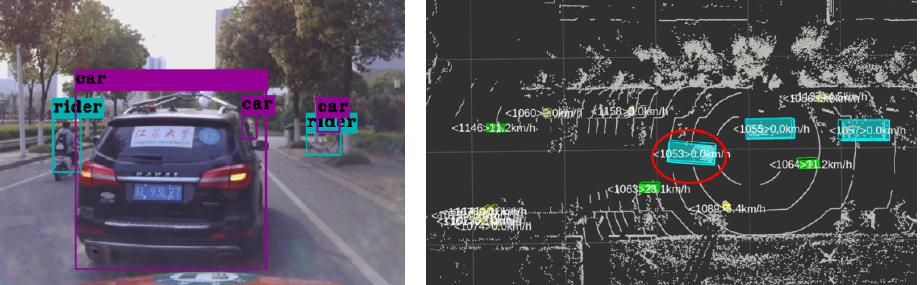
Figure 11. Visualized output of mobile platform perception results.